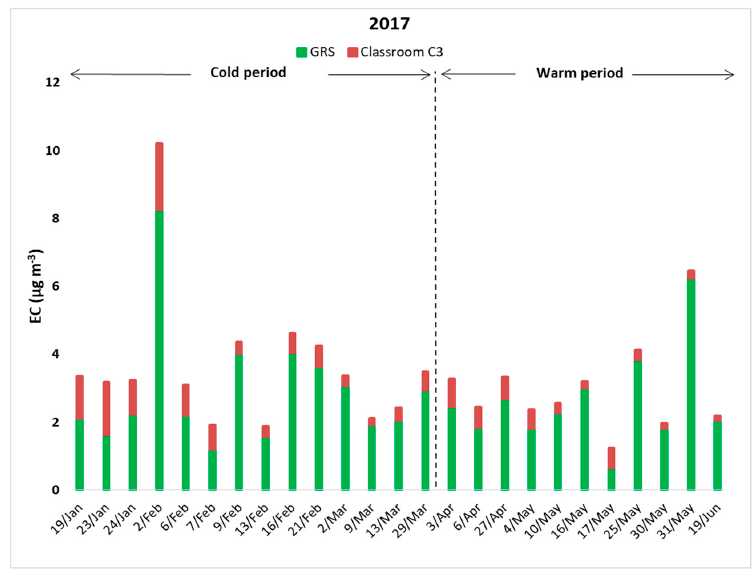
Figure 4. Indoor and outdoor EC concentrations for all sampling days.